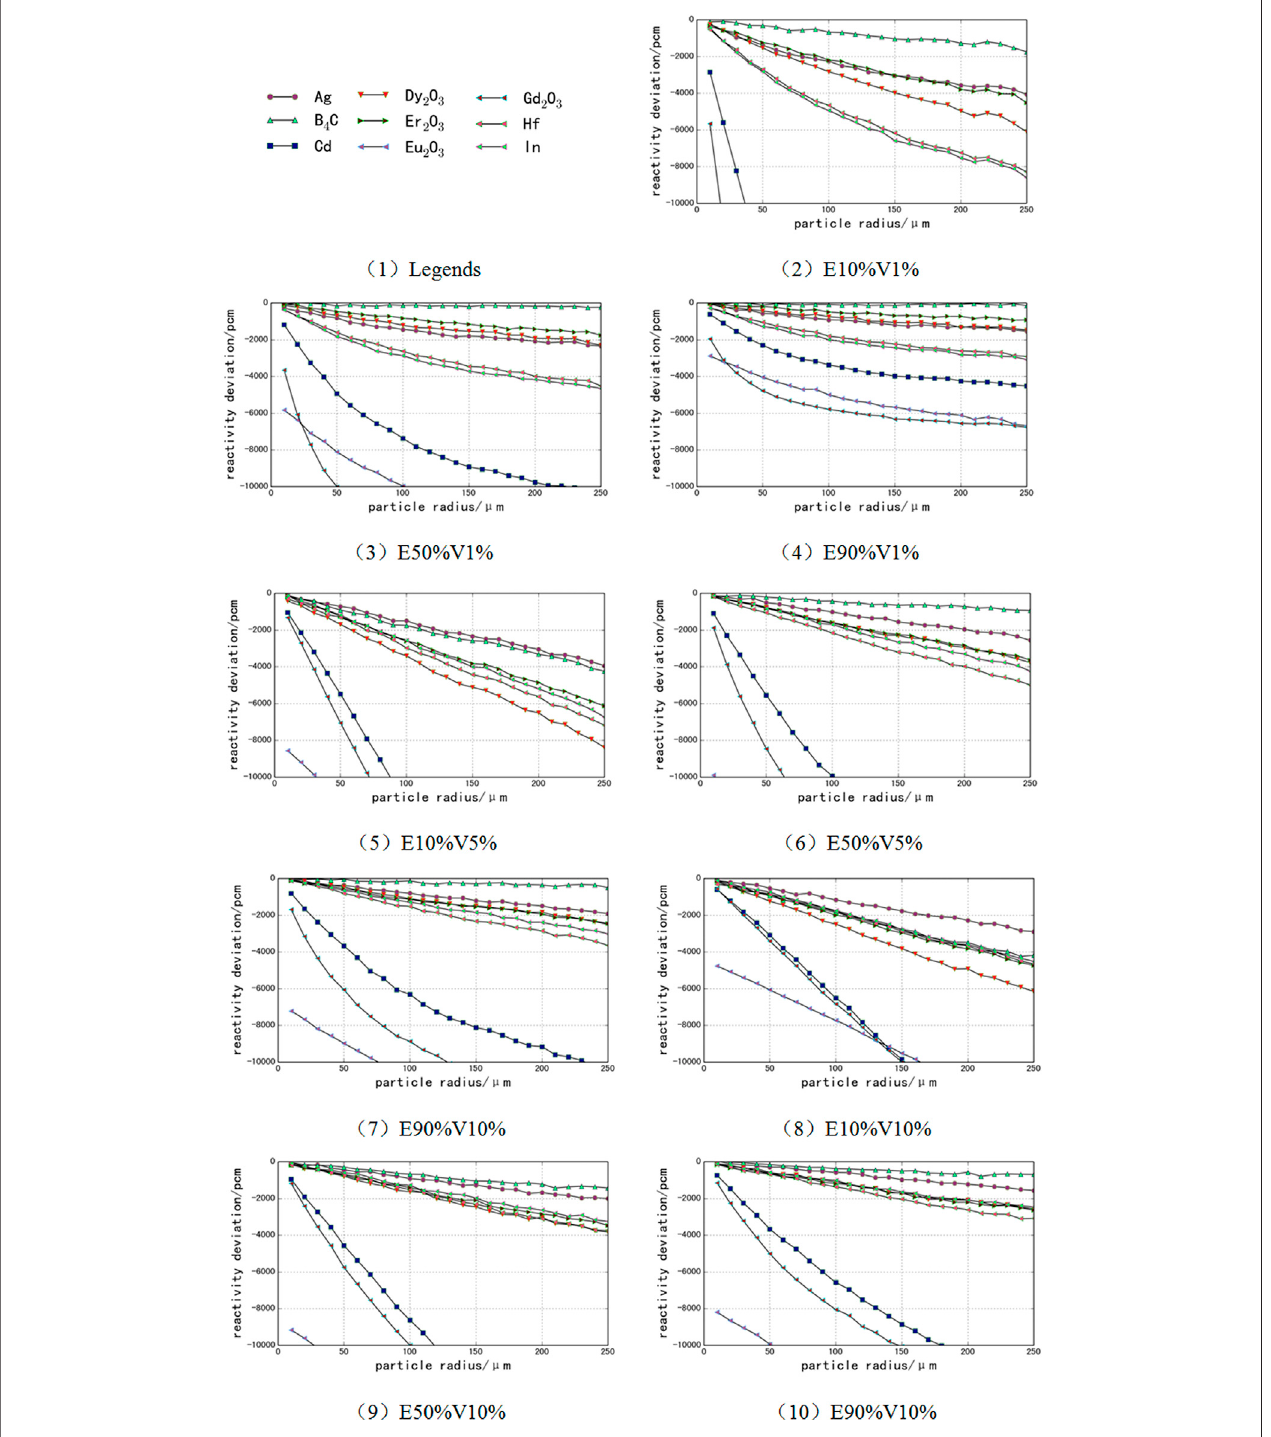
FIGURE 3 | Reactivity calculation deviation curve of different burnable poisons.